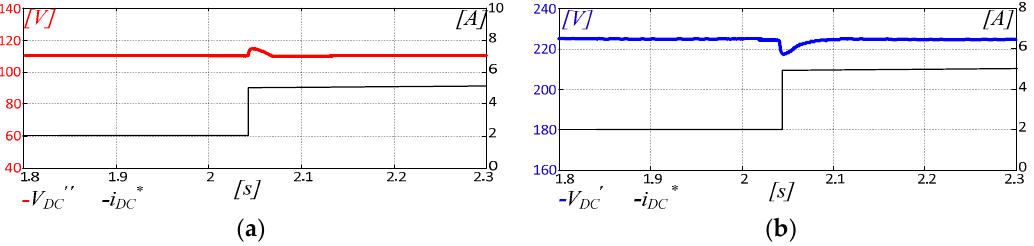
Figure 19. SimPower System model. Load variation i DC* . ( a ) TLI DC bus voltage V DC ''. ( b ) Output voltage V DC ' .